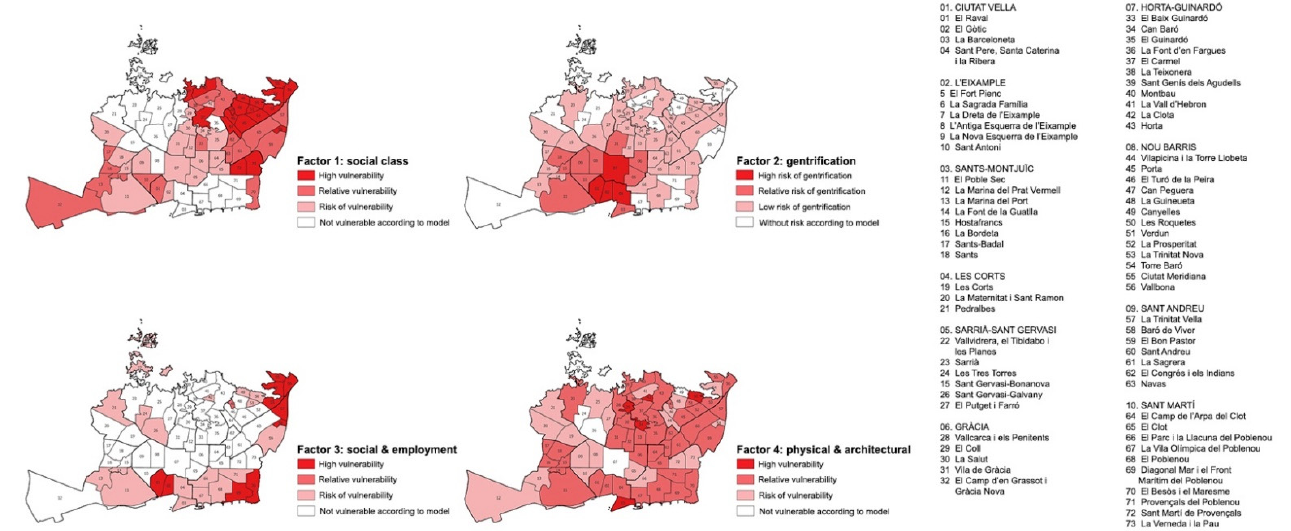
Figure 1. Maps identifying the dimensions of the vulnerability obtained from the factor analysis, linked to social class, gentrification, social and employment, and physical and architectural dimensions, showing the 73 neighbourhoods of Barcelona. Prepared by the authors.